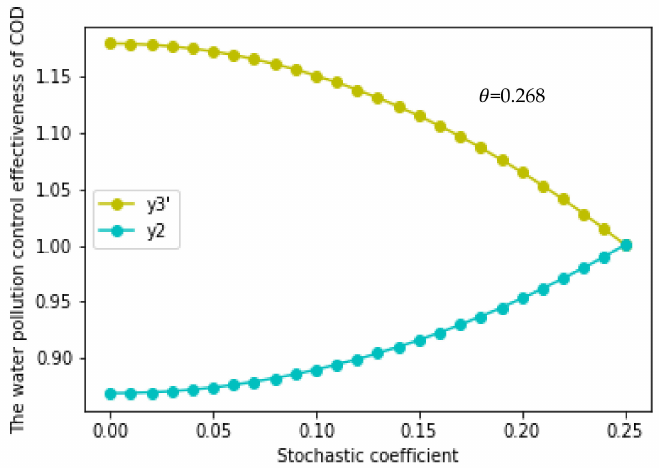
Figure 6. The interval of the reward and punishment coe ffi cient ( θ ) to ensure the validity of the